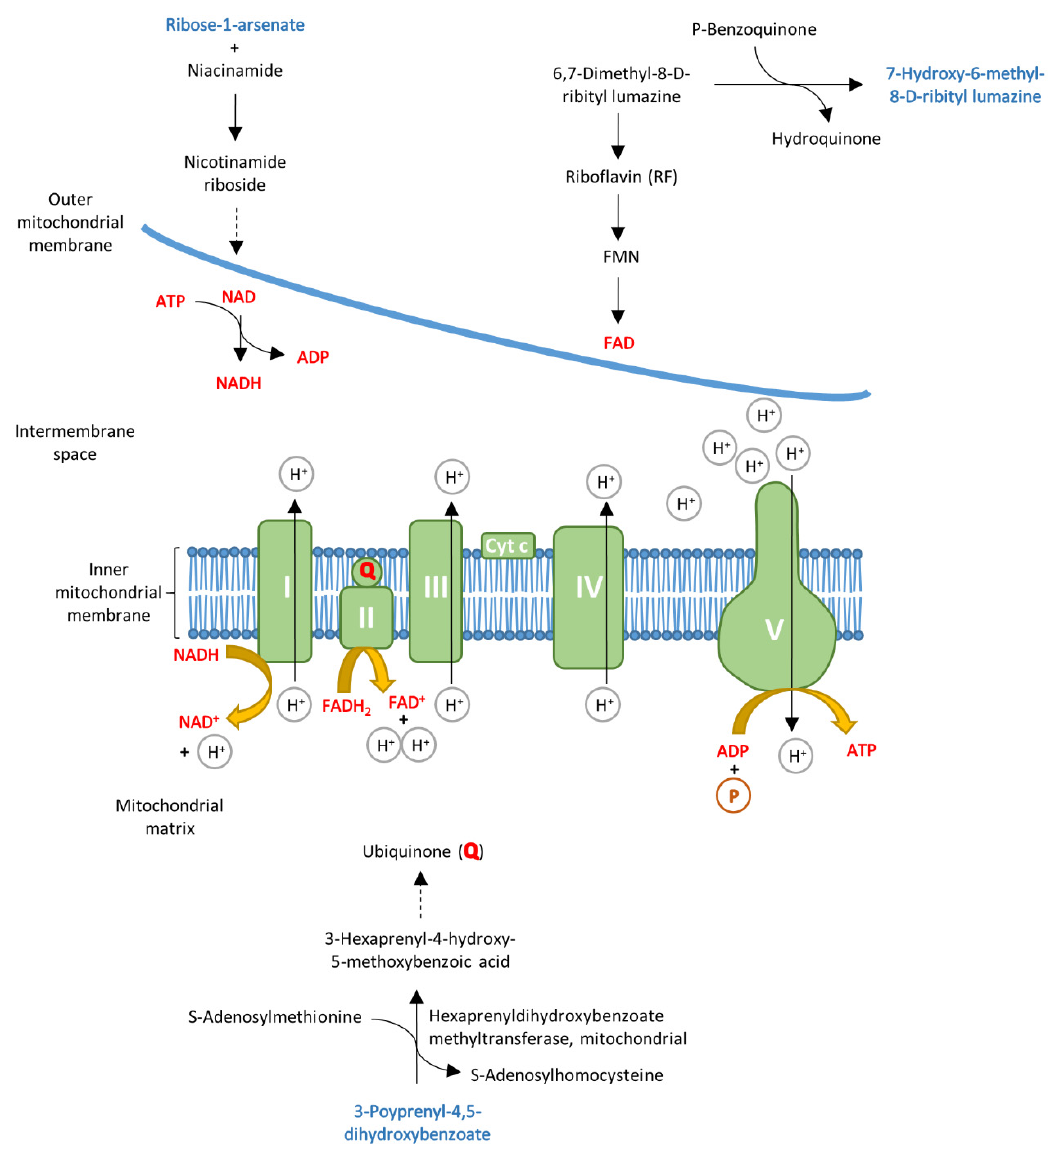
Figure 5. Schematic overview of the mitochondrial electron transport chain. Some of the top 30 metabolites (highlighted in blue) could be linked to energy metabolism, as they are involved in pathways that lead to essential molecules of the electron transport chain, which are highlighted in red.